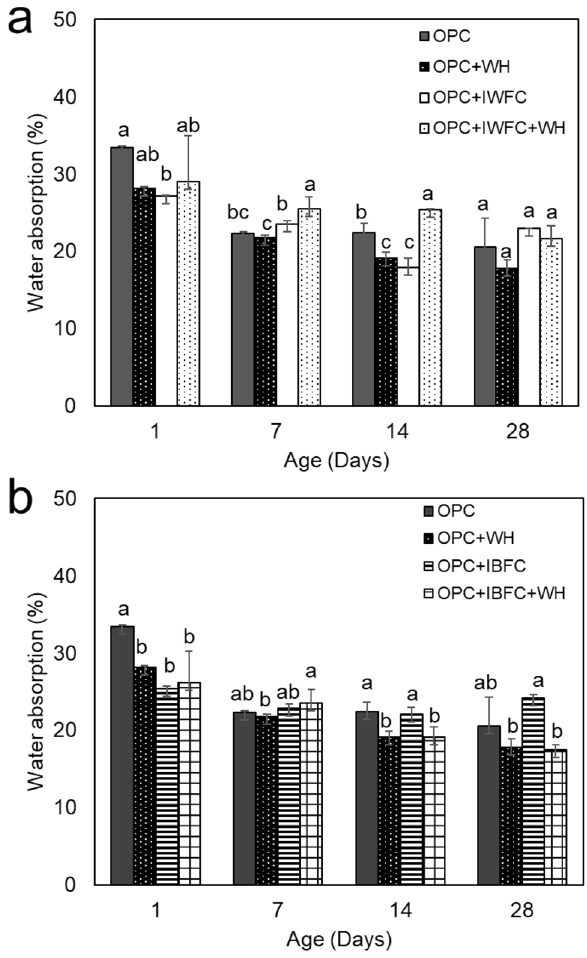
Figure 3. Water absorption of cementitious composites containing IWFC ( a ) and IBFC ( b ). Error bars represent standard deviations of the data. Different letters above the bars indicate significant difference at p -value < 0.05 when compared using the Least Significant Difference method (LSD). Data with different letters are significantly